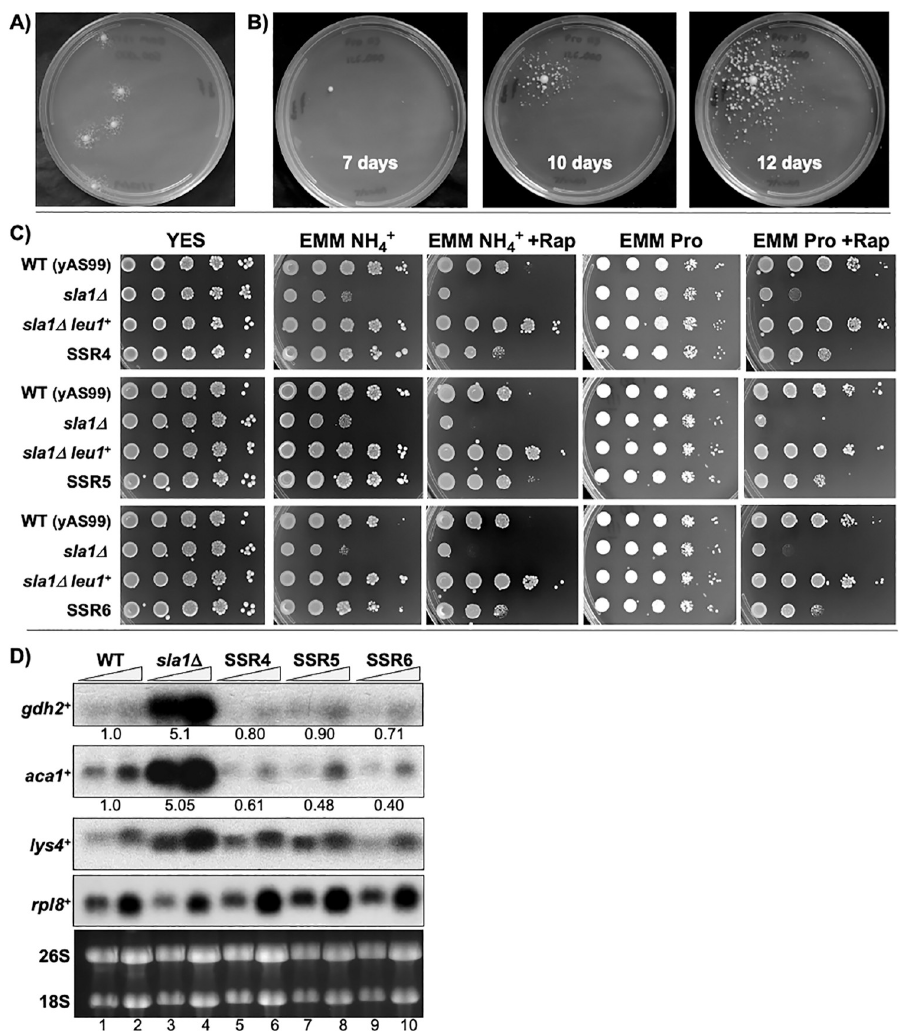
Fig 3. Characterization of spontaneous sla1 Δ slow growth revertants (SSRs). A) Results of plating sla1 Δ cells (yAS113) on EMM-NH4 + . B) 250,000 sla1 Δ cells plated and photographed after incubation for 7, 10 and 12 days. C) WT (yAS99) sla1 Δ (yAS113), and a leu1 + transformant of yAS113, sla1 Δ leu1 + , is shown alongside SSR4, SSR5 and SSR6 in the three sets. Rapamycin was used at 50 ng/ml. D) Northern blot of 5 and 10 μ g total RNA from the strains indicated above the lanes grown in EMM-NH4 + probed for ghd2 + , aca1 + , lys4 + and rpl8 + mRNAs as in Fig 2. Numbers under the panels indicate the average of duplicate quantification measurements of the bands relative to rpl8 + which serves as quantitative normalization relative to WT which was set to 1 as in Fig